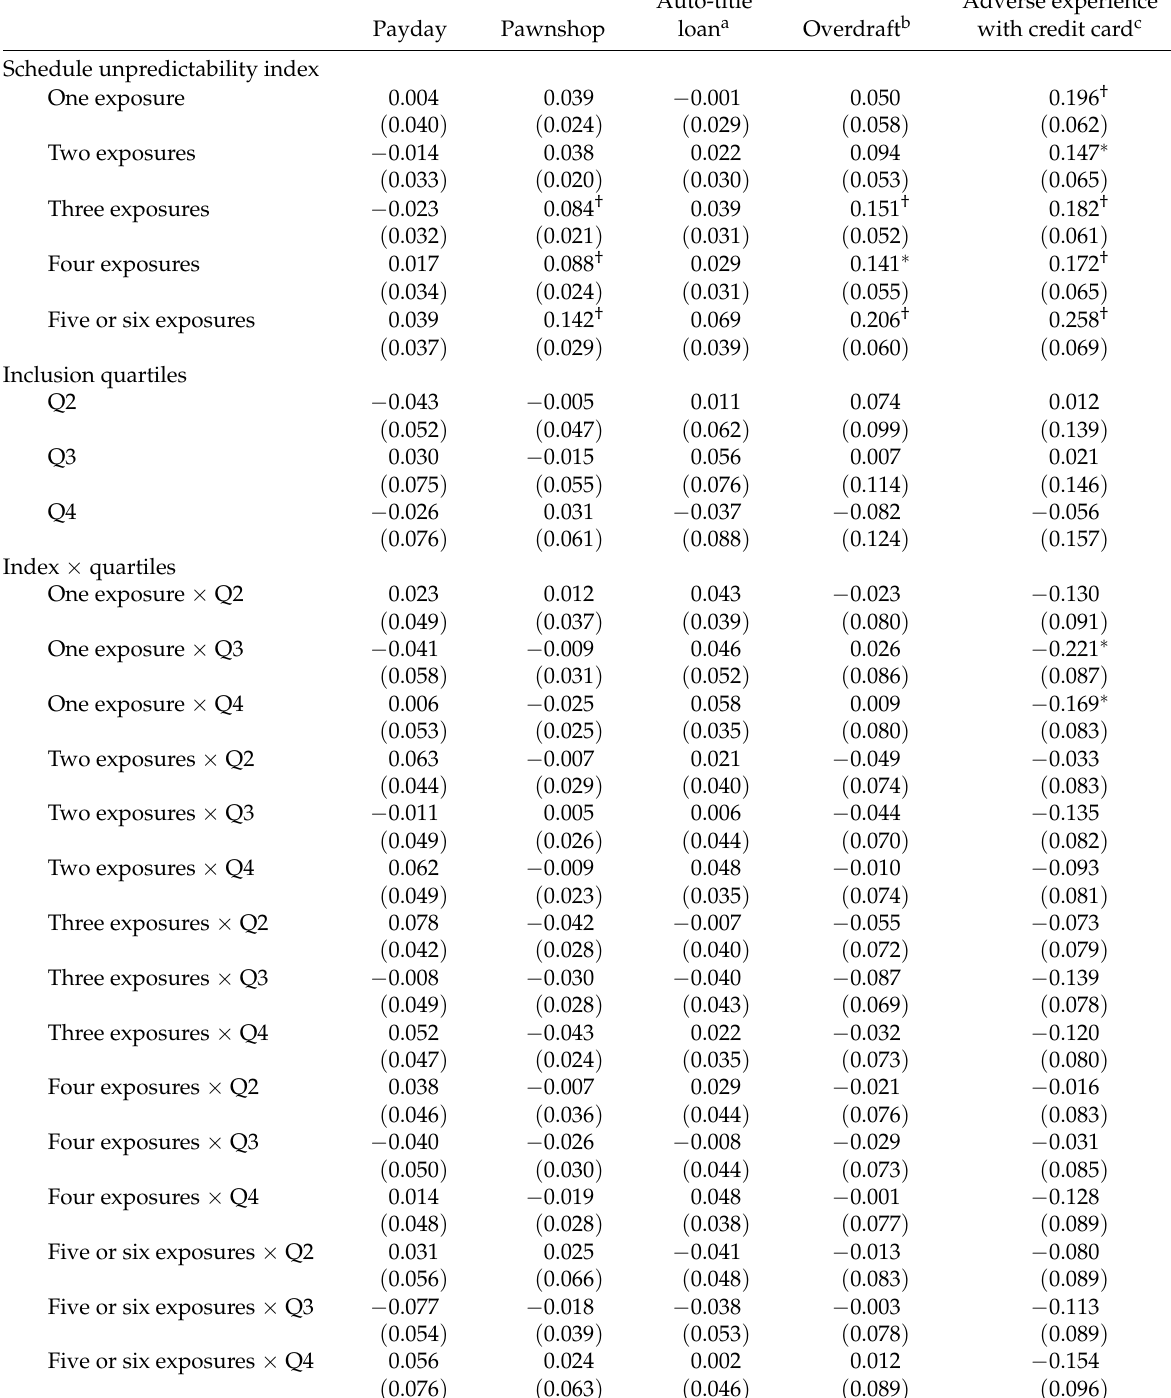
Table 6: Coefficients from linear probability models